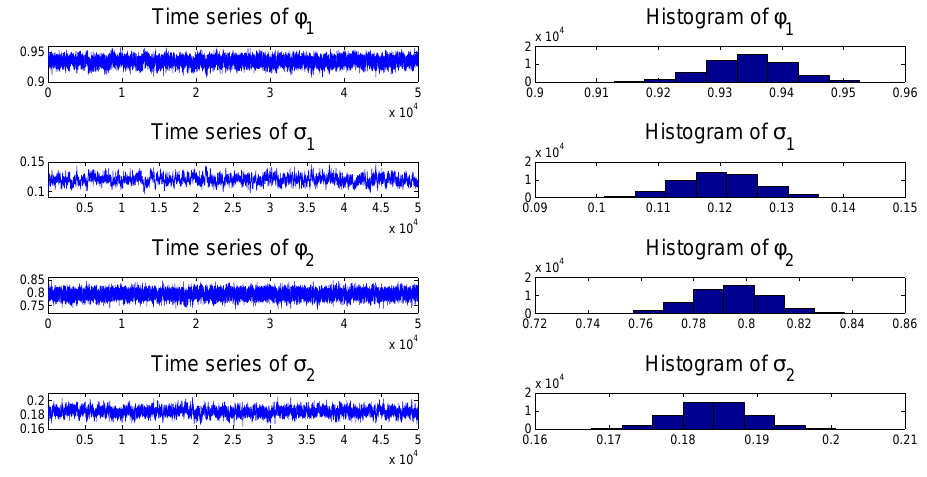
Figure 2. Time series and histograms of the samples drawn from the full conditionals of the parameters in the AR(1) process of the TSCD-W model based on the simulated duration data.